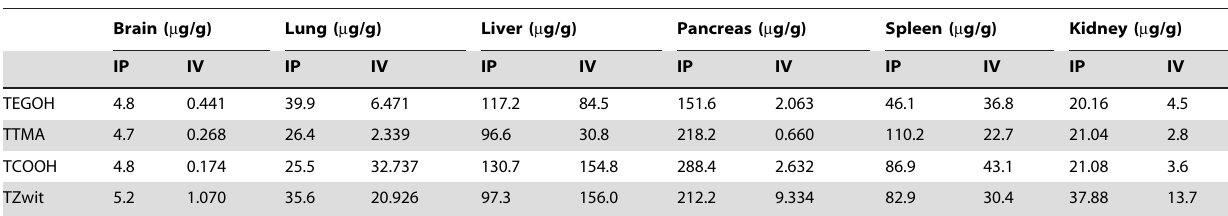
Table 2. Biodistribution Study.